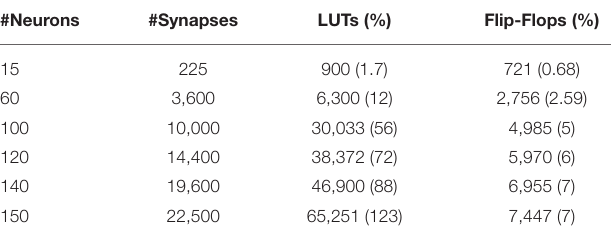
TABLE 3 | Resource utilization reported for multiple ONN size for Xilinx 7-series FPGA.